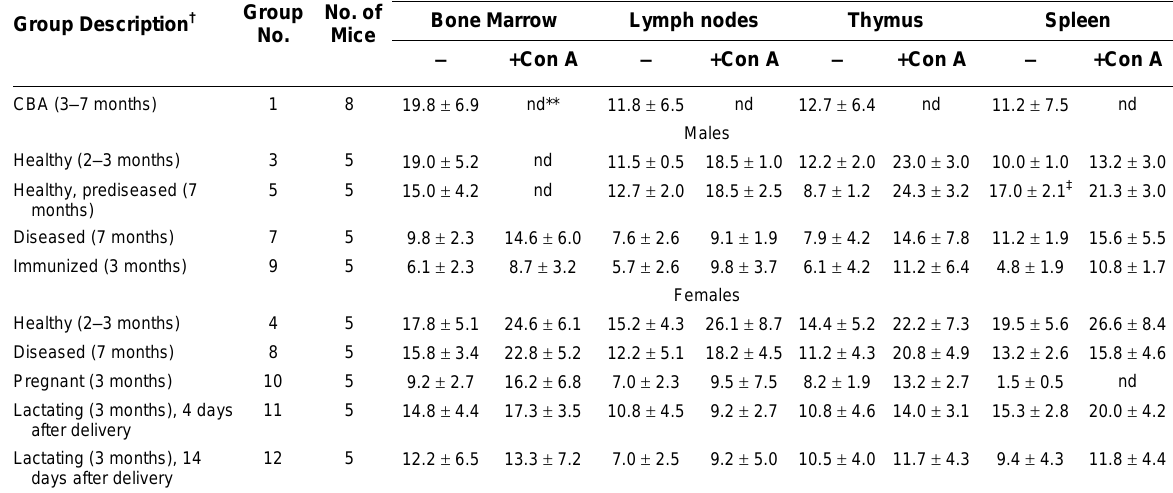
Apoptosis in MRL-lpr/lpr Mouse Organs in the Presence and in the Absence of Concanavalin